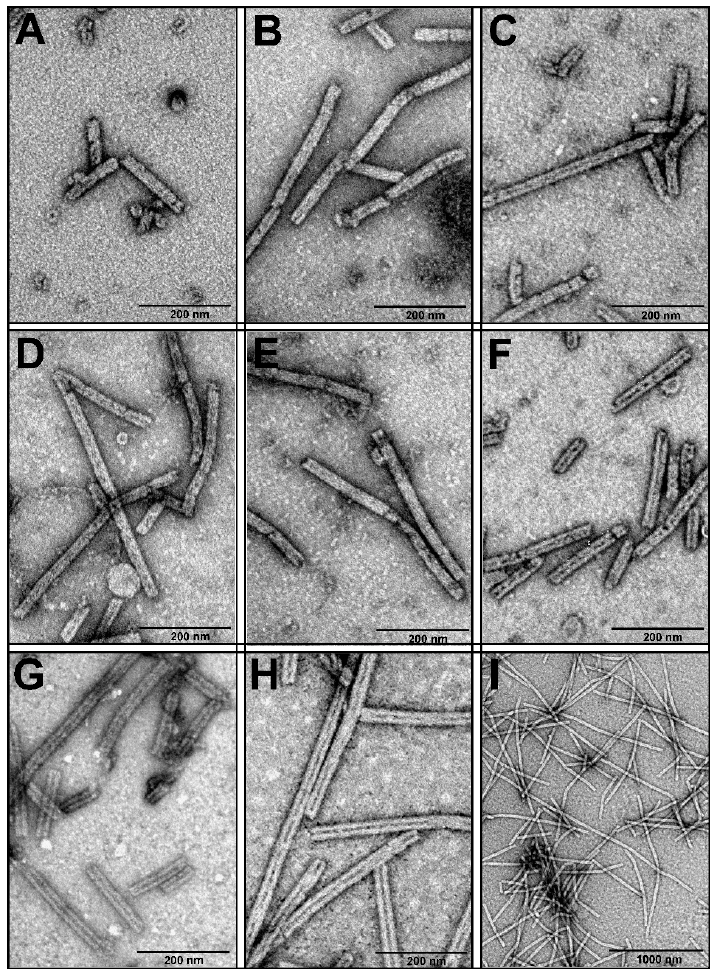
Figure 7. Electron micrographs of the polysheaths formed by the gp053 mutants. ( A ) gp053_N-his, ( B ) gp053_C-his, ( C ) gp053_N Δ 9_C Δ 11, ( D ) gp053_N Δ 9-his_C Δ 11, ( E ) gp053_N Δ 25-his_C Δ 25, ( F ) gp053_N Δ 20, ( G ) gp053_C Δ 76, and ( H , I ) gp053_C Δ